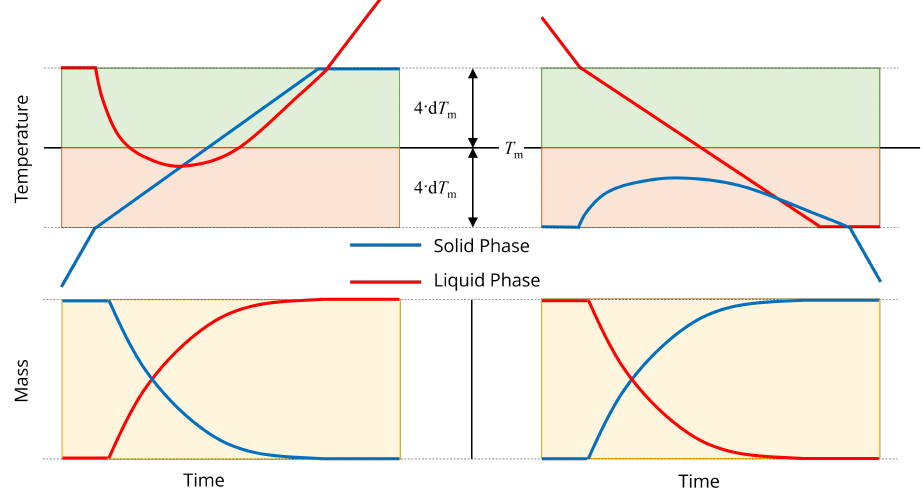
Figure 2. Illustration of ( left ) melting and ( right ) freezing. T m indicates the steel melting temperature and d T m is a constant used for calculating the rates of melting and